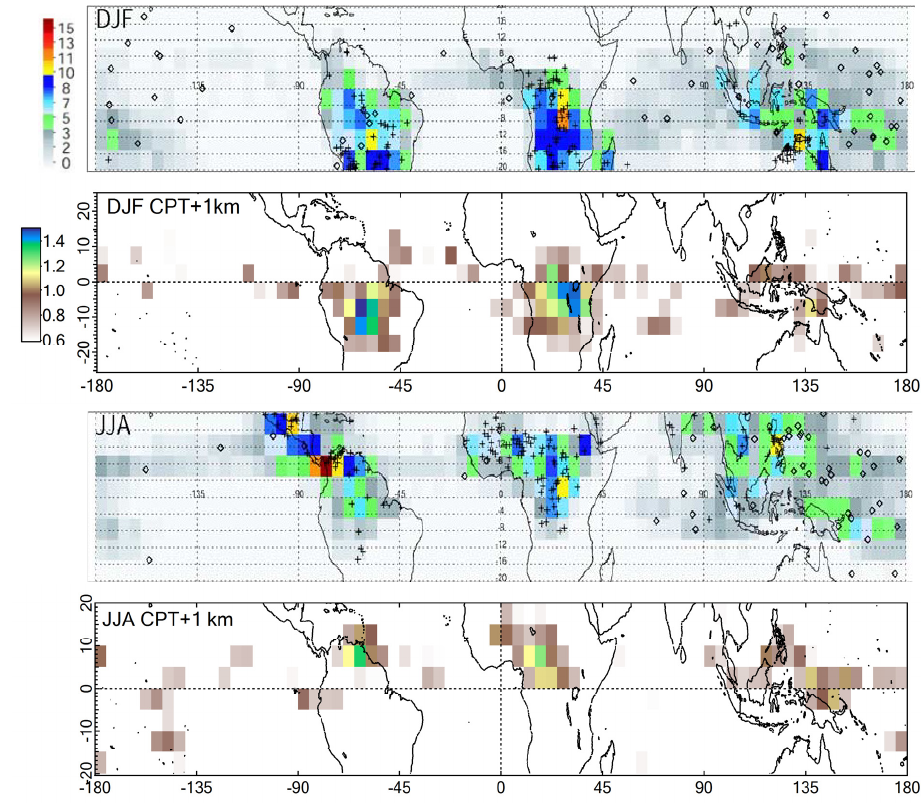
Fig. 5. Comparison between geographical locations of late-afternoon cooling in the 1km-thick layer above the local cold point tropopause (2nd and 4th panels) and TRMM OPF density number above 14km (1st and 3rd panels, adapted from LZ05). Top panels: DJF; bottom: JJA. The OPF frequency of occurrence is in units per thousand in each bin divided by the TRMM 3A25 total pixel number for removing the sampling bias. The color scale of the cooling is the value of the mean difference between late afternoon (18:00 ± 02:00) and morning (10:00 ± 02:00)